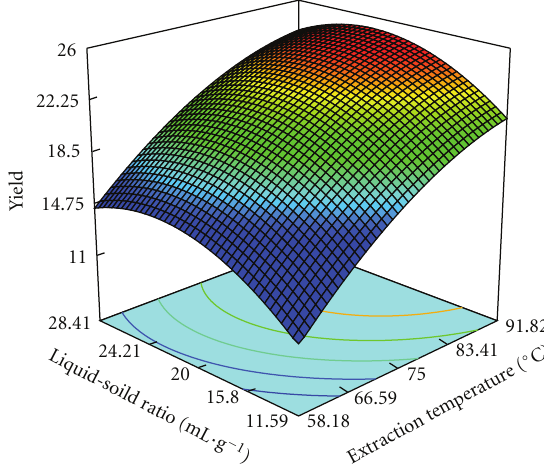
Figure 4: Response surface and contours of the e ff ect of liquid-solid ratio and extraction temperature on the yield of pectin.